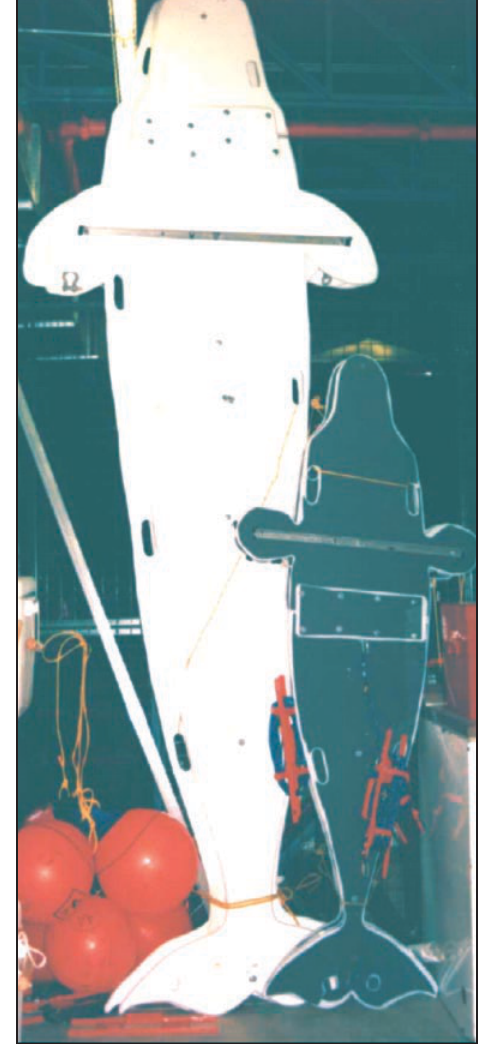
Fig. 2. Beluga models (white adults and grey juveniles) used to estimate the visi- bility of belugas to aerial